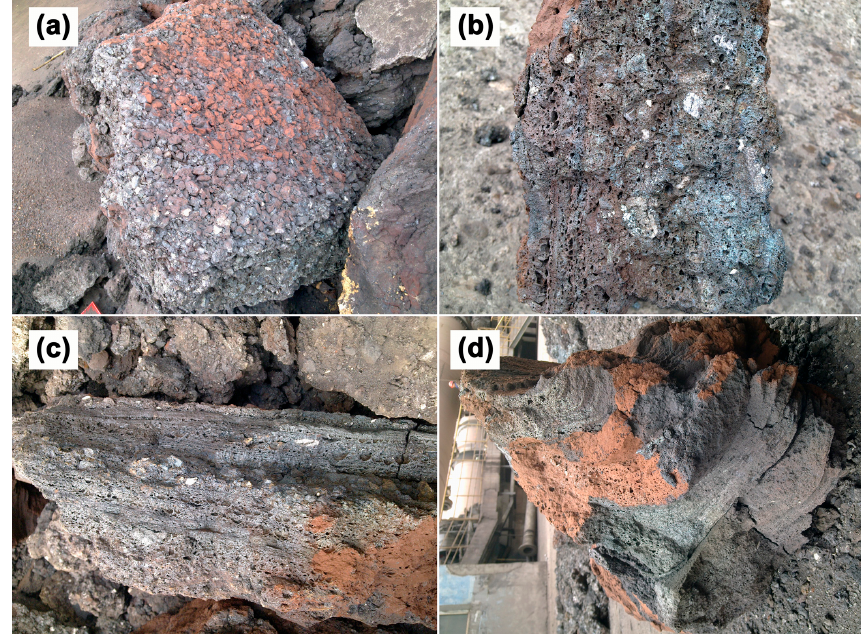
Figure 3. Digital photos of deposit samples collected from different locations in rotary kiln: ( a ) S1 with adhered limonite granules on surface; ( b ) characteristics of the longitudinal section of S1; ( c ) characteristics of the longitudinal section of S2; ( d ) appearance characteristics of S3.